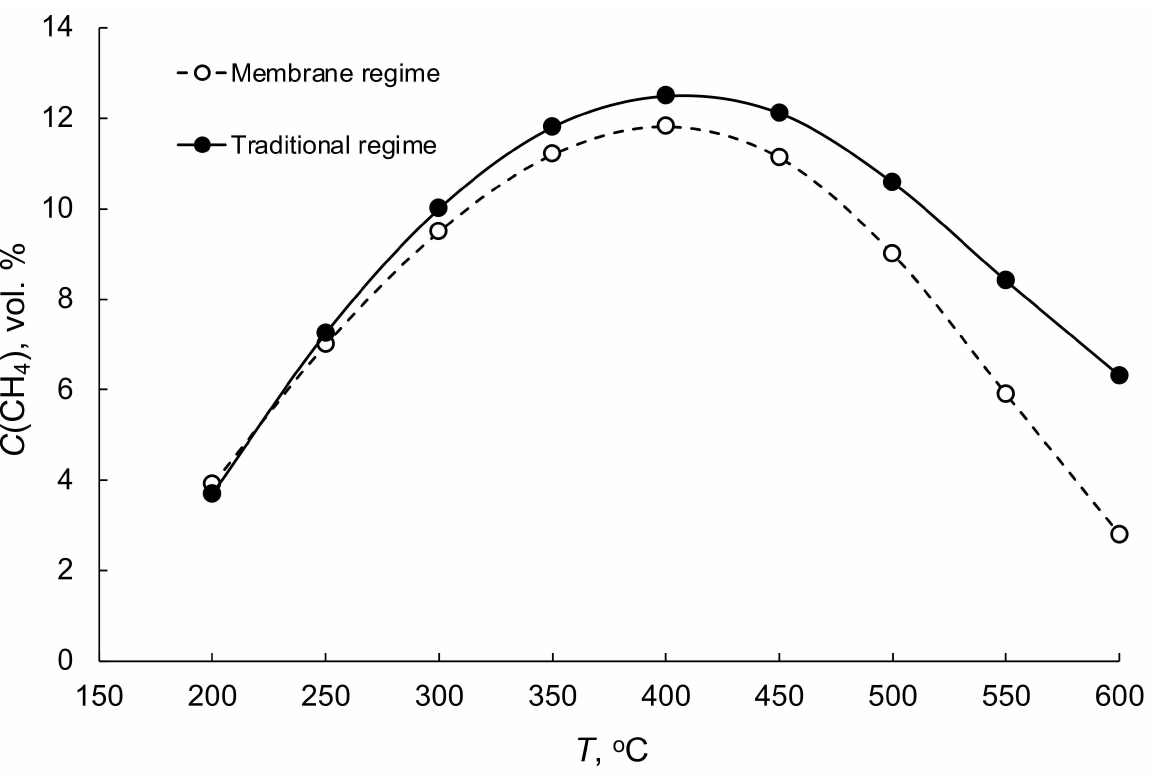
Figure 8. Comparison of the temperature dependences of methane concentrations in the re- action products of the carbon dioxide reforming of ethanol carried out in the membrane and traditional